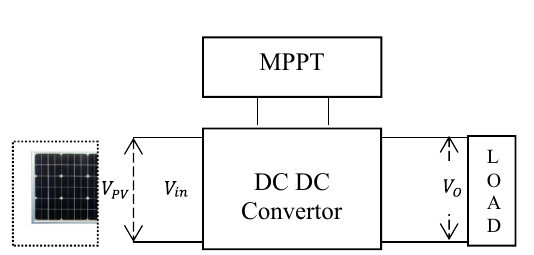
Fig. 2 Solar power system components block diagram